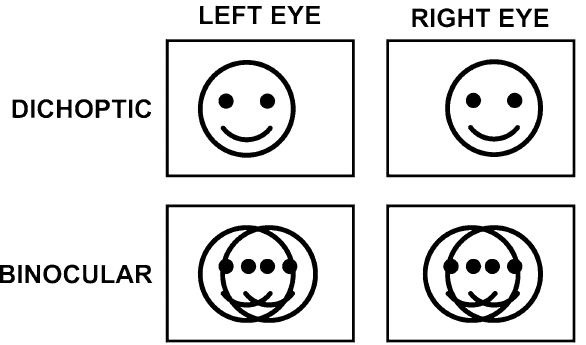
Figure 5. Top: Demonstration of a dichoptically presented disparity used in the diplopia threshold estimation task. The left eye image is slightly closer to the left side of the reference frame and the right eye image is slightly closer to the right side of the frame. This small disparity should result in the cartoon face appearing nearer than the reference frame if convergence is used to fuse the images. In this case, an observer should report seeing one face; if they are experiencing diplopia, they should report seeing two faces. Bottom: Example of a binocular stimulus used in the control condition. This stimulus has the same separation between the faces as the top row, but both faces are presented to both eyes. This stimulus should always lead to a report of seeing two characters. Note: the rectangular boxes used for illustration here were not included in the actual stimulus. The stimuli used in the experiment were green images of Pokemon characters, which have been replaced here with cartoon faces for copyright